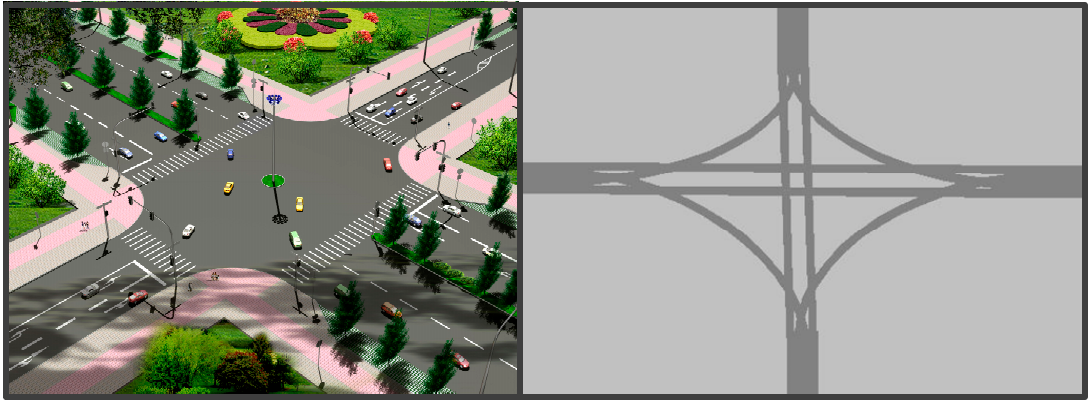
Figure 5. Real scene and simulation scene.